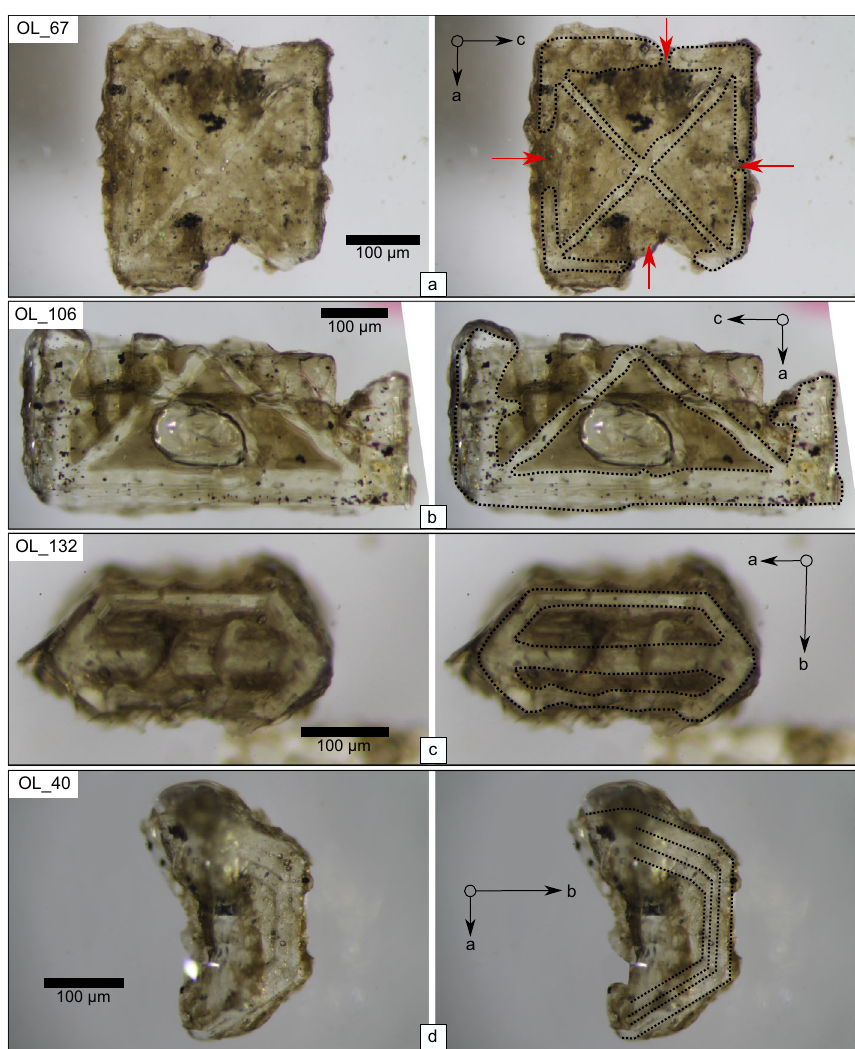
Fig. 1 Examples of dendritic and skeletal textures preserved in olivine phenocrysts of Los Hornitos, raw images (left) and their interpretation (right). a – c Group 3 type olivines, see text for details on the groups, a Olivine 67 oriented normal to b axis showing the four dendrites radiating from the central core, partially enclosing the external section, leaving cavities fi lled with melt (red arrows) connected to the exterior of the crystal. b Olivine 106 broken along the (100) plane, oriented normal to b axis. This crystal is fully enclosed along the c direction and shows in detail the morphology of the dendrites and the fully entrapped melt. c Olivine 132 oriented normal to c axis showing the two cavities enveloping the central crossbar along the a axis. d Olivine 40 irregularly broken along plane (010) oriented normal to c axis. This crystal denotes the layered texture resultant of the progressive external growth of crystal frames, promoting the occurrence of a thin melt fi lm between two adjacent growth layers. We consider this crystal part of group 2. Examples for each group are shown also in Supplementary Information Fig.